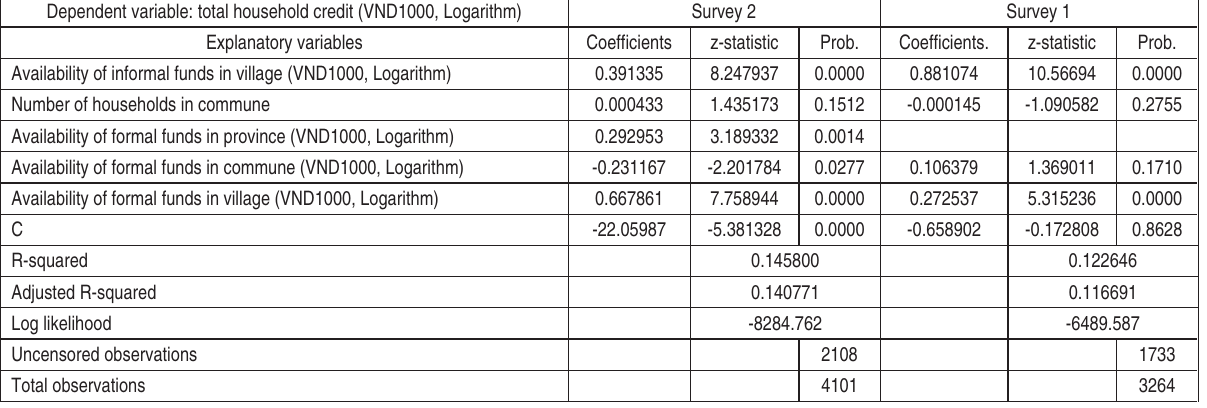
Table 1 (cont.). First stage Tobit regression: determinants of household credit. The whole samples Dependent variable: total household credit (VND1000,